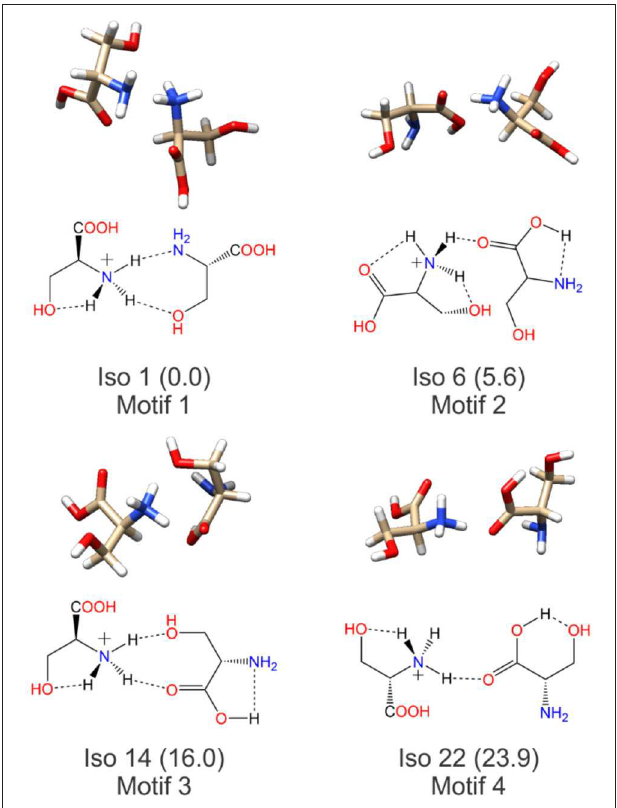
FIGURE 5 | The lowest energy isomers for each low energy binding motif of the protonated serine dimer. Motifs 1 and 3 show bidentate coordination between the two moieties, whereas motifs 2 and 4 exhibit monodentate coordination between the two moieties.